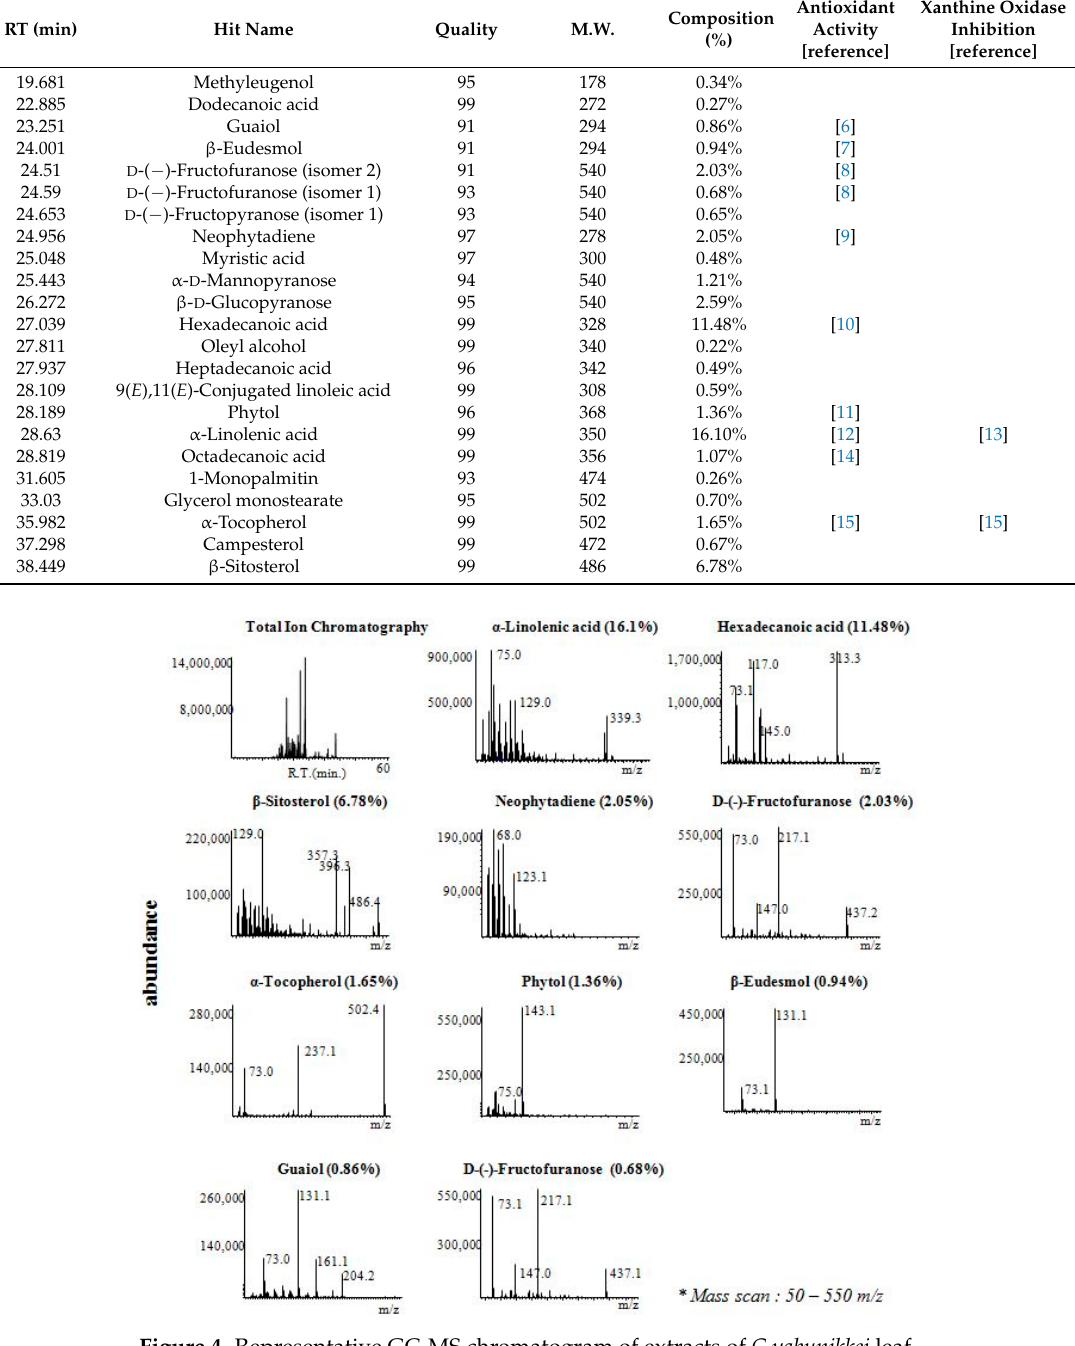
Figure 4. Representative GC-MS chromatogram of extracts of C.yabunikkei leaf.